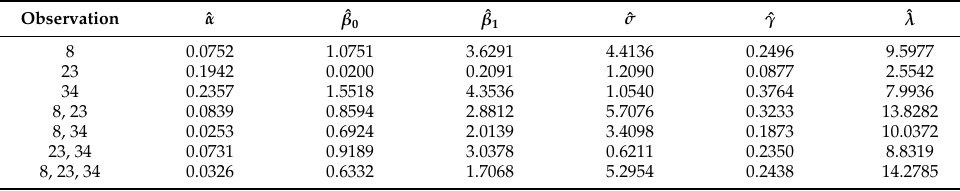
Table 5. Relative change of the estimates of the EGSHN